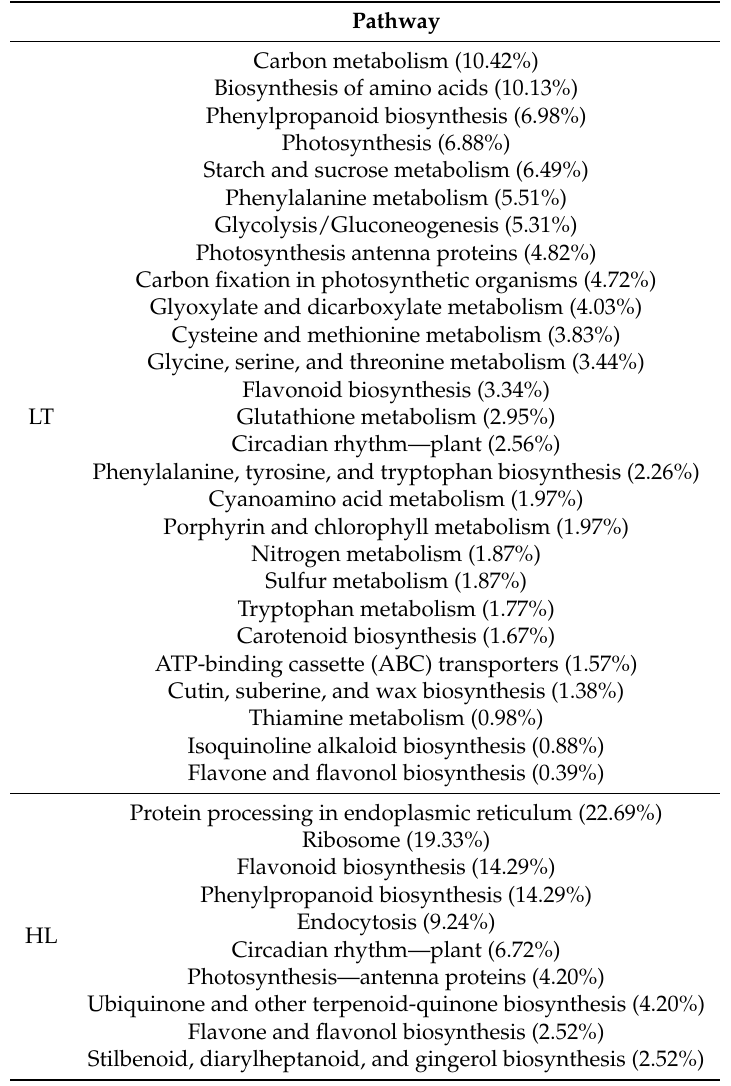
Table 3. Kyoto Encyclopedia of Genes and Genomes (KEGG) analysis of differentially expressed genes (DEGs) detected in the comparison of LT vs. CK and HL vs. CK in B. semperflorens leaves. LT, low temperature-treated plants; HL, high light-treated plants; CK, control